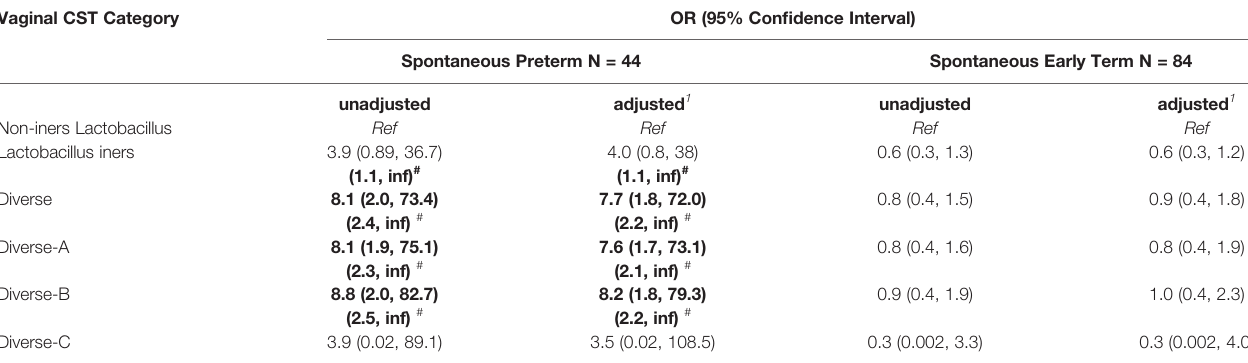
TABLE 6 | Odds of Birth Outcome According to CST (5-Category) (Full Term = Referent) . Vaginal CST